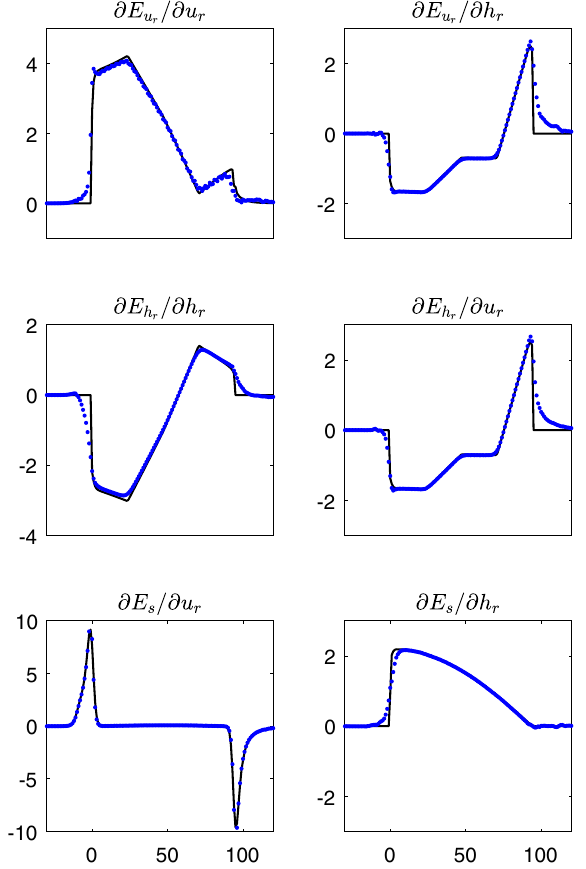
FIG. 8. Electric field gradients (in 10 7 Vm − 1 ) along the path length of the inflector (in mm), obtained from a 3D TOSCA model. The dotted lines are the numerical field gradients, and the solid lines are the gradients calculated according to Eq.